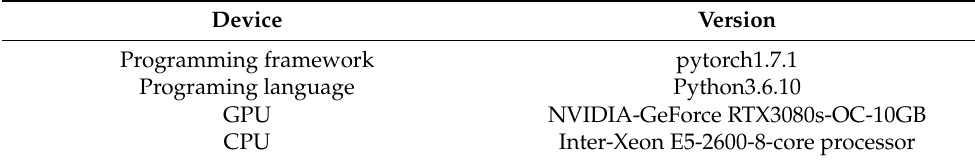
Table 2. Training environment and equipment.